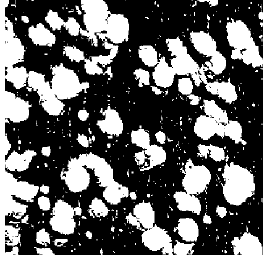
Table 4. Gray statistical characteristic values of the corrosion morphology image . Cl − Concentration Average Gray Value Standard Deviation